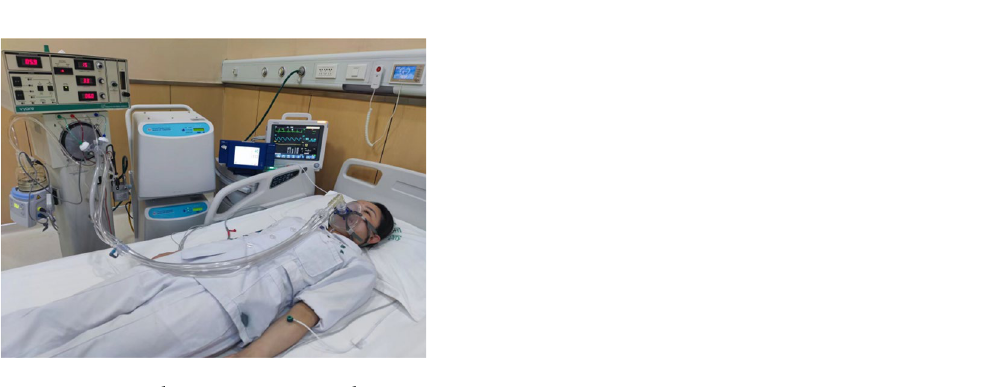
Figure 4. One volunteer is training with